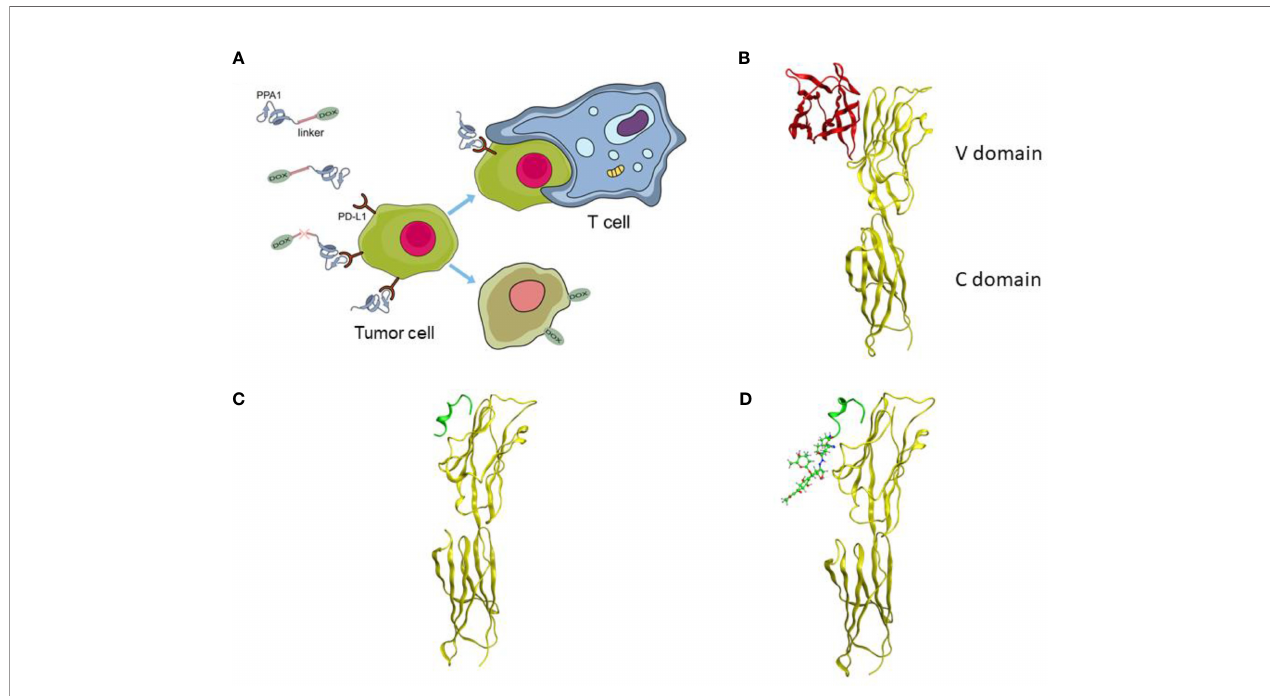
FIGURE 1 | The design of the polypeptide-drug conjugate (PPA1-DOX). (A) The mechanism of tumor inhibition by PPA1-DOX. (B) The crystal structure of the PD-1/ PD-L1 complex from Protein Data Bank (PDB ID: 3BIK). (C) The structure of PD-L1/PPA1 from molecular dynamic simulation. (D) The structure of PD-L1/PPA1-DOX from molecular dynamic simulation. The yellow ribbon structure stands for PD-L1; The red ribbon structure stands for PD-1; The green ribbon structure stands for PPA1; The green stick and ball molecule stands for DOX.